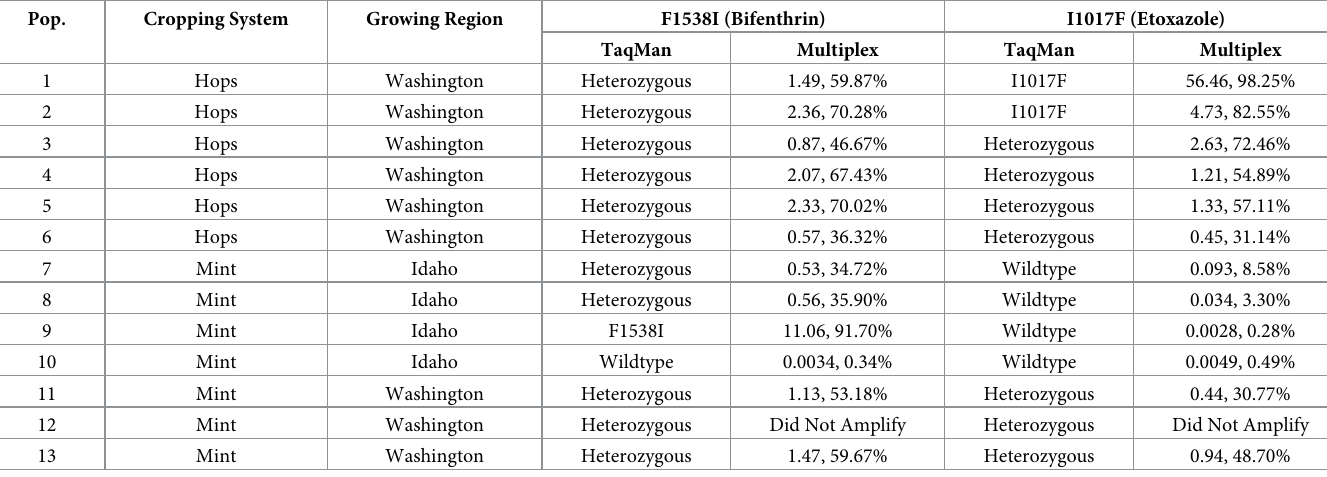
Table 2. Comparison between TaqMan qPCR and multiplex PCR results in T . urticae collected from hops and mint in the Pacific Northwest.